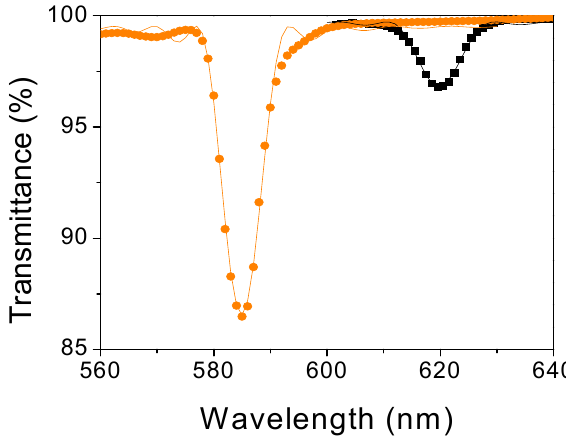
Figure 5. Transmittance of reflection gratings recorded at 550 mJ/cm 2 for recording (black squares) and curing (orange circles) stages as a function of reconstruction wavelength. The spatial frequency of the gratings was 4738 lines/mm and d h = 150 µ m. Solid lines represent the theoretical fit through Kogelnik’s coupled wave theory. Errors are ± 0.3% in the transmittance and ± 1 nm in the wavelength. Table 1. Parameters obtained from theoretical fit of the experimental transmittance values. H (mJ/cm 2 ) Cured ∆ n d ( µ m) ∆ n · d ( µ m) Λ ( µ m) DE max